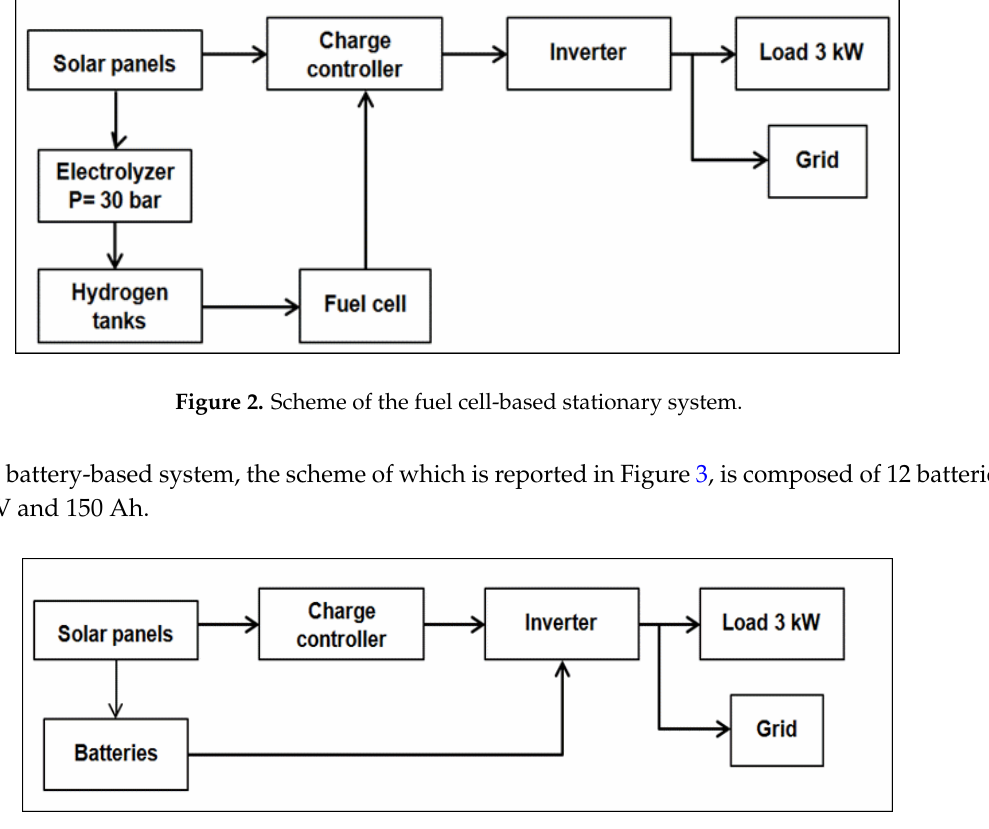
Figure 3. Scheme of the battery-based stationary system.